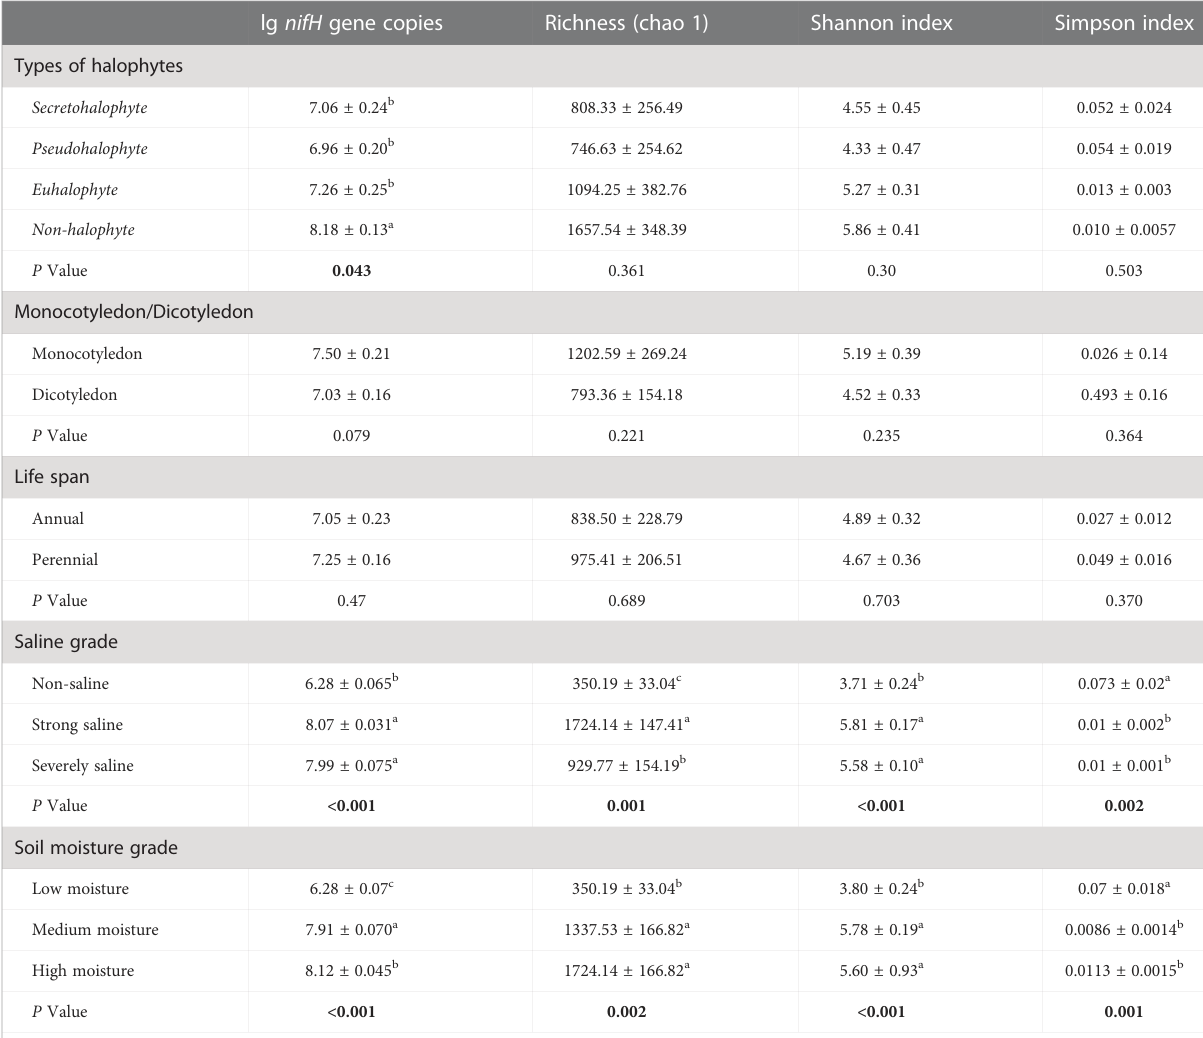
TABLE 2 Comparison of the abundance and diversity of nitrogen- fi xing bacteria from the rhizosphere of different plant species. lg nifH gene